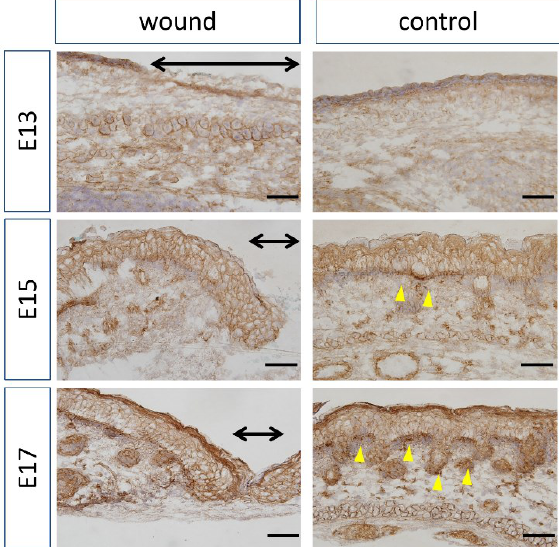
Figure 4. Localization of β -catenin by immunohistochemistry. The range of the wound is indicated by a yellow arrow. Brown: β -catenin. Purple: Hematoxylin. Black arrow: Area of the wound. Scale bar = 100 μm.